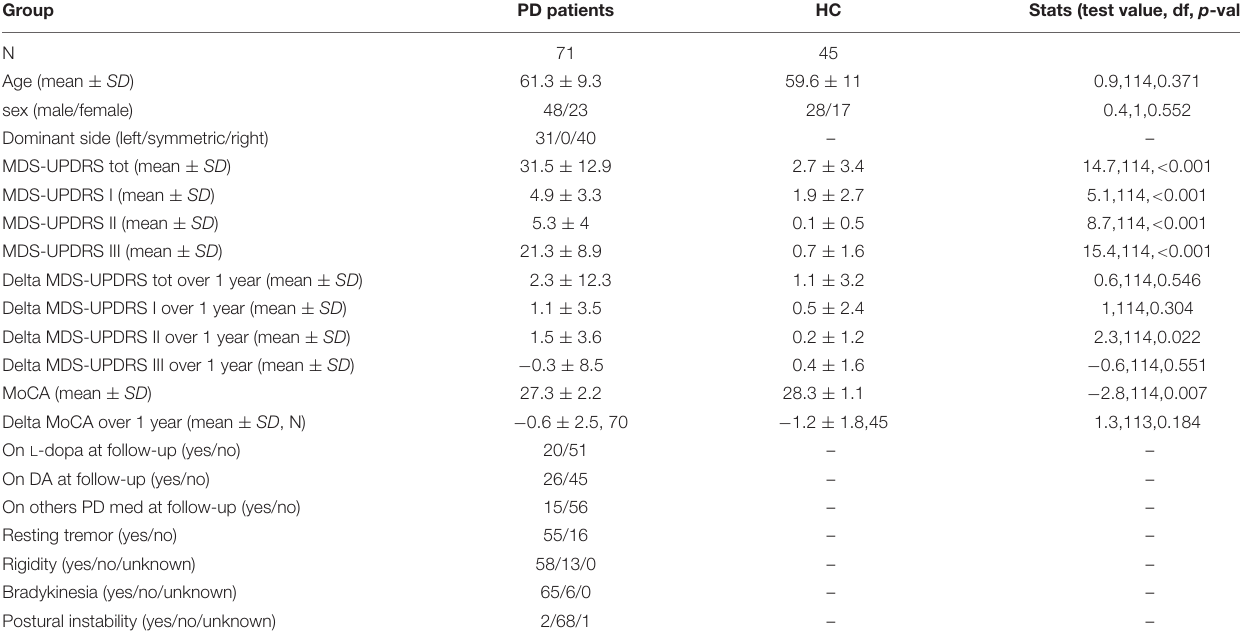
TABLE 1 | Subject group